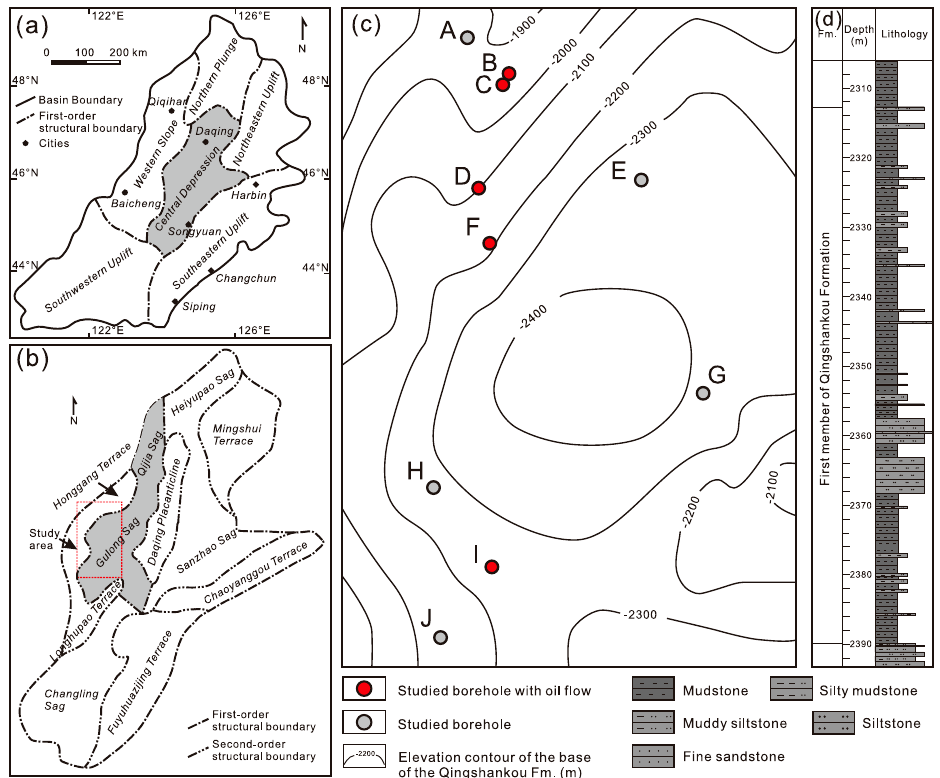
Figure 1. Generalized map showing the division of the tectonic units in ( a ) the Songliao Basin and ( b ) the Central Depression. ( c ) Base contour map of the first member of the Qingshankou Formation (K 2 qn 1 ) in the Gulong Sag. ( d ) Lithologic sketch of K 2 qn 1 .